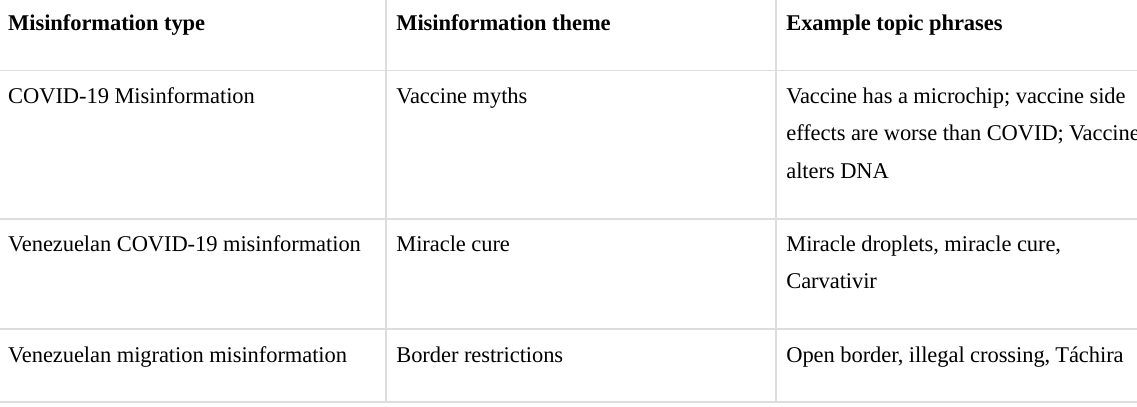
Table 1. Summary of themes and